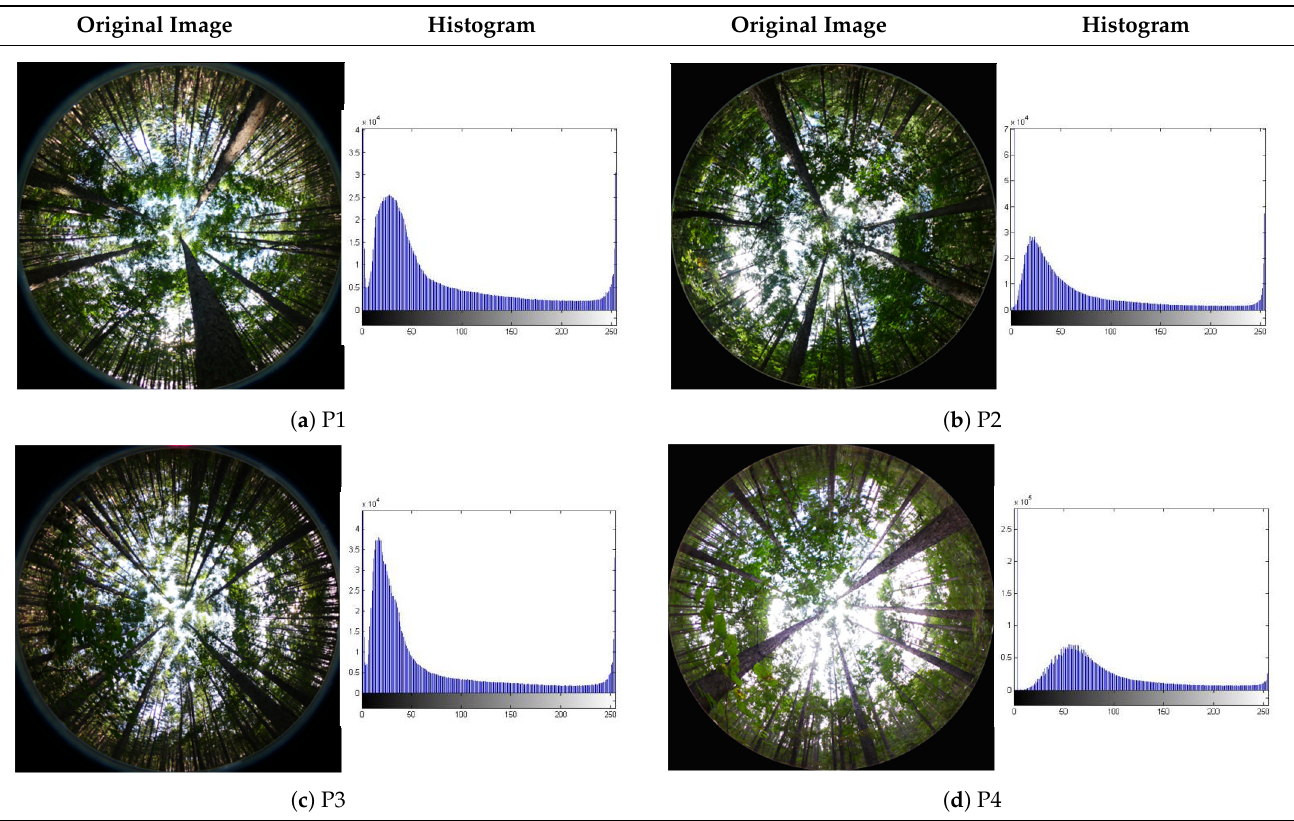
Table 4. Original benchmark images and the corresponding histograms.